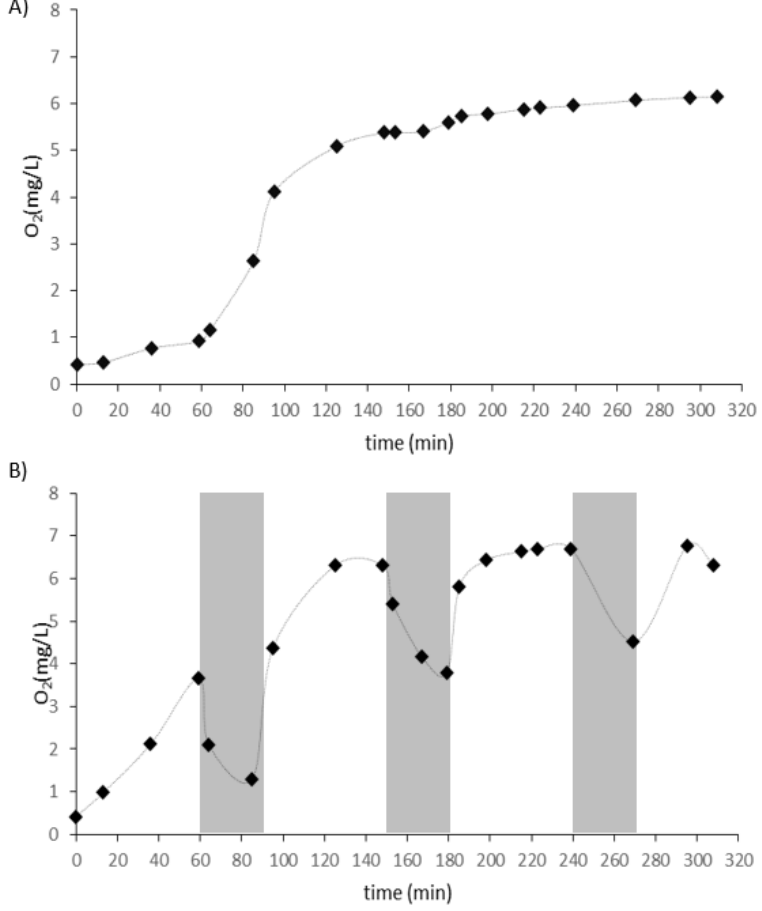
Figure A1. Changes of oxygen concentration in reactors cycle in ( A ) reactor R 1 and ( B ) R 2 . Gray shading indicates phases without aeration.